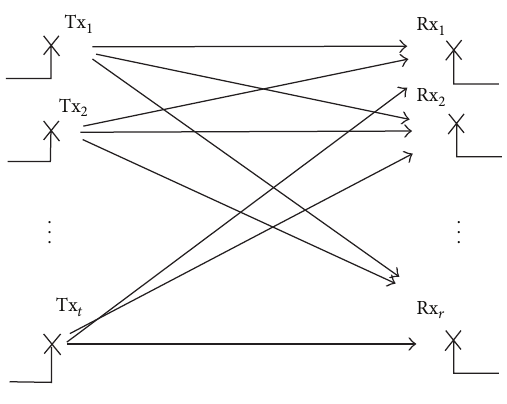
Figure 2: MIMO transmitter and receiver scheme.